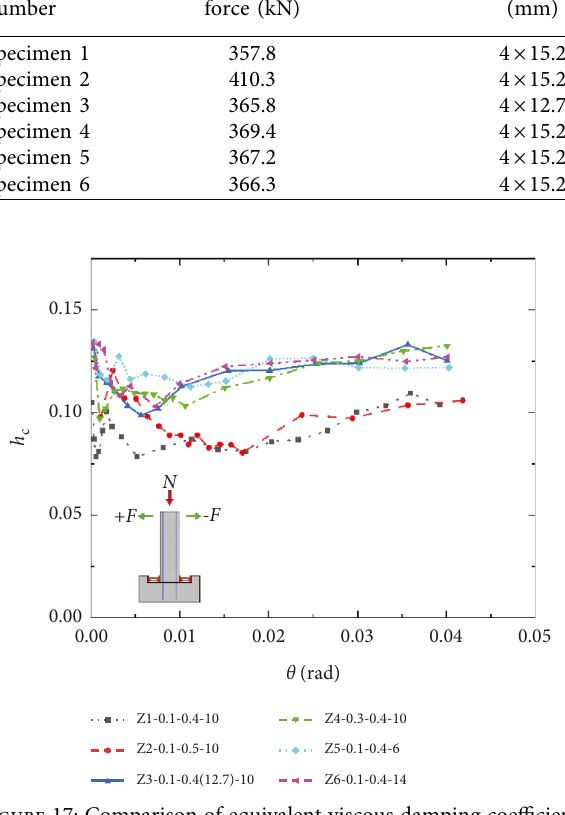
Figure 17: Comparison of equivalent viscous damping coefficient h c curves. Figure